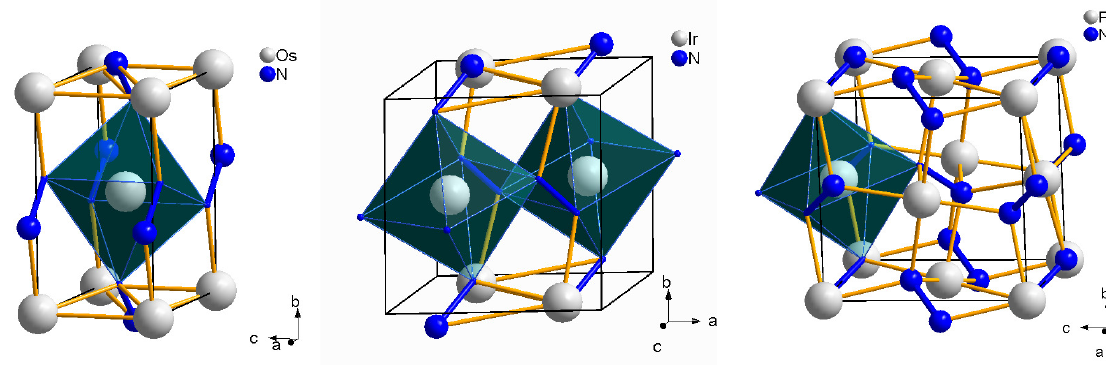
Figure 10. Crystal structures of orthorhombic OsN monoclinic IrN of CoSb - or arsenopyrite-type structure (center, [69,70]) and cubic PtN 2 2 pyrite-type structure (right,